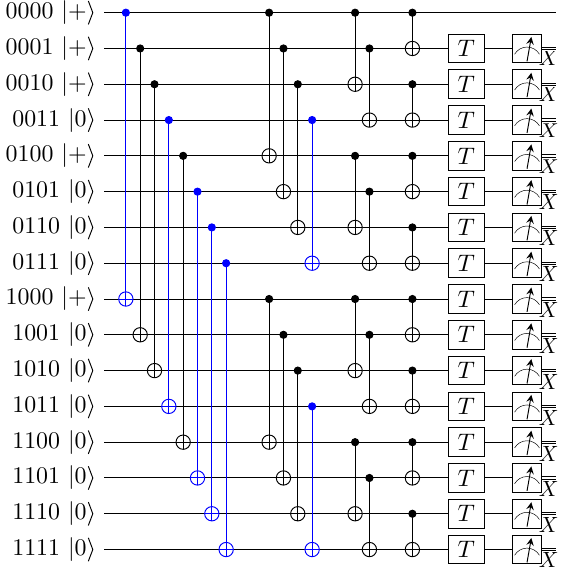
FIG. 8. A 15-to-1 state-distillation circuit as the r = 1 instance of the Haah-Hastings construction. Each qubit is labeled by a string of 3 r + 1 bits, and if the bit string has weight at most r , then that qubit is prepared in the |+(cid:2) state, otherwise in the | 0 (cid:2) state. In the j th round of CNOT gates, we apply CNOT s between the pairs of qubits with bit string differing only at the j th position. Note that the blue CNOT s are redundant as their control or target qubits are | 0 (cid:2) or |+(cid:2) , respectively. The resulting state is | Q 1 (cid:2) ∝ |+(cid:2)|+(cid:2) + |−(cid:2)|−(cid:2) , where in our case |+(cid:2) and |−(cid:2) are code states of the 15-qubit Reed-Muller code. We then apply the transversal T gate and measure every nonpunctured qubit in the X basis to infer the measurement outcomes m i ’s for X stabilizers and m for the logical X . The protocol rejects if m i = − 1 for some i . If there are no faults, then the remaining unpunctured qubit is in the state T 3 − 2 m X |+(cid:2)